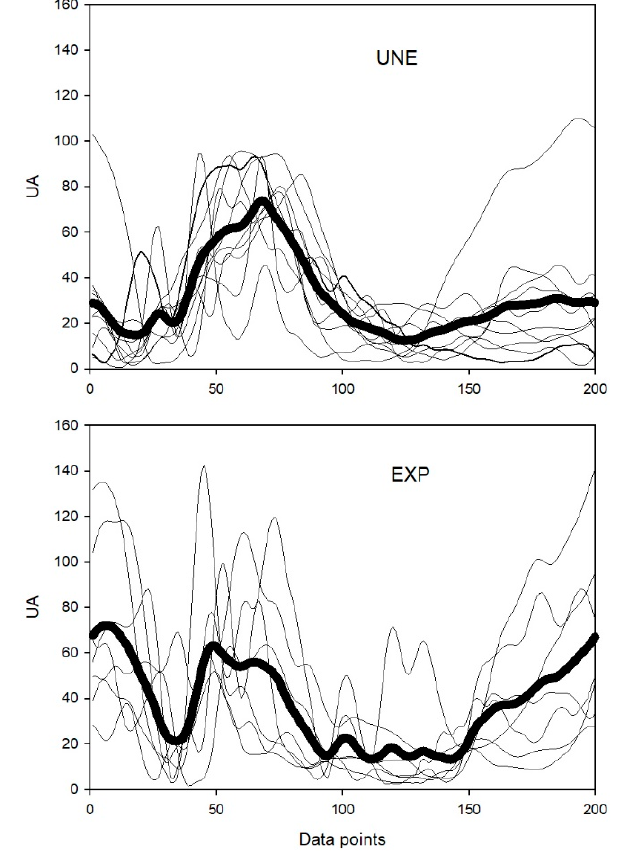
Figure 2. Inter-individual variability of Synergy #3 activation coefficients (UA—arbitrary units). Bottom panel corresponds to weightlifters’ group while top panel regards to unexperienced participants’ group. The thick black line represents the group mean, while the thin lines represent individual synergy activation coefficients.